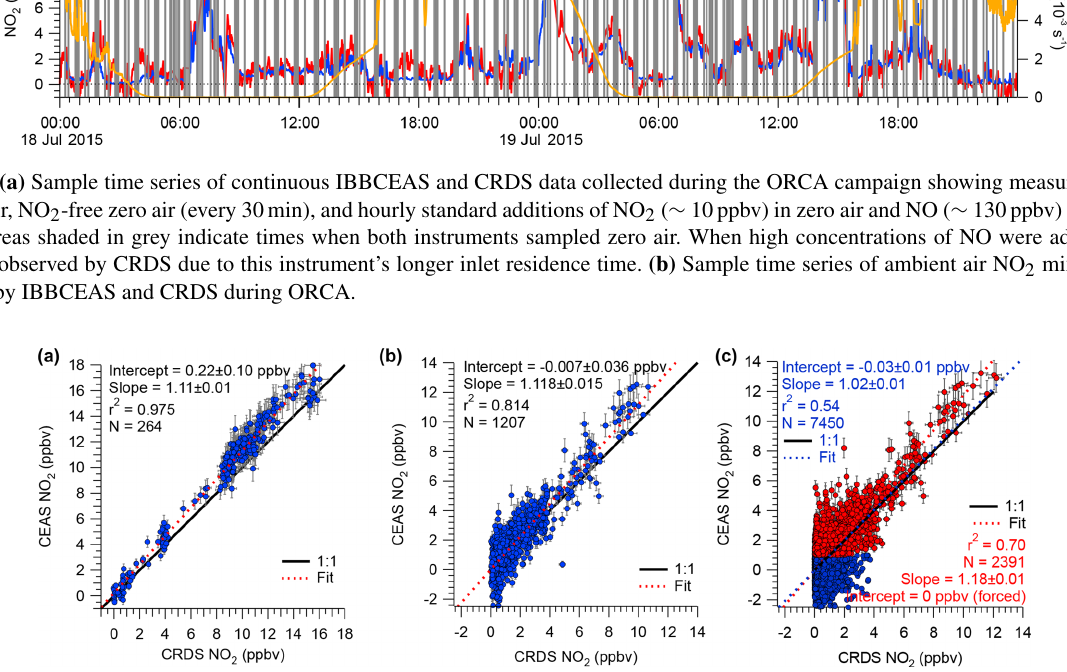
pled at a flow of 1.5 slpm and cell pressure of 890 hPa,